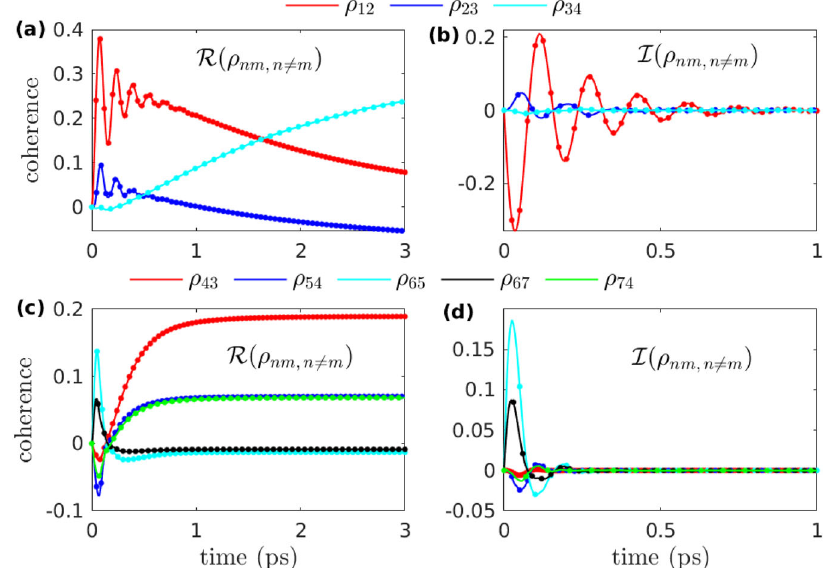
Fig. 3 Electronic coherence as a function of time. a and b , respectively, show the real and imaginary parts of the prominent off-diagonal terms for Fig. 2a, b, where γ = 175, λ = 70, T = 70 with the initial excitation on site-1. c and d , respectively, show the real and imaginary part of the prominent off-diagonal terms for Fig. 2c, d, where γ = 75, λ = 100, T = 130 with the initial excitation on site-6. The results of AI-QD are compared to the results of LTLME-QD (dots). γ and λ are in units of cm − 1 , while T is in the units of